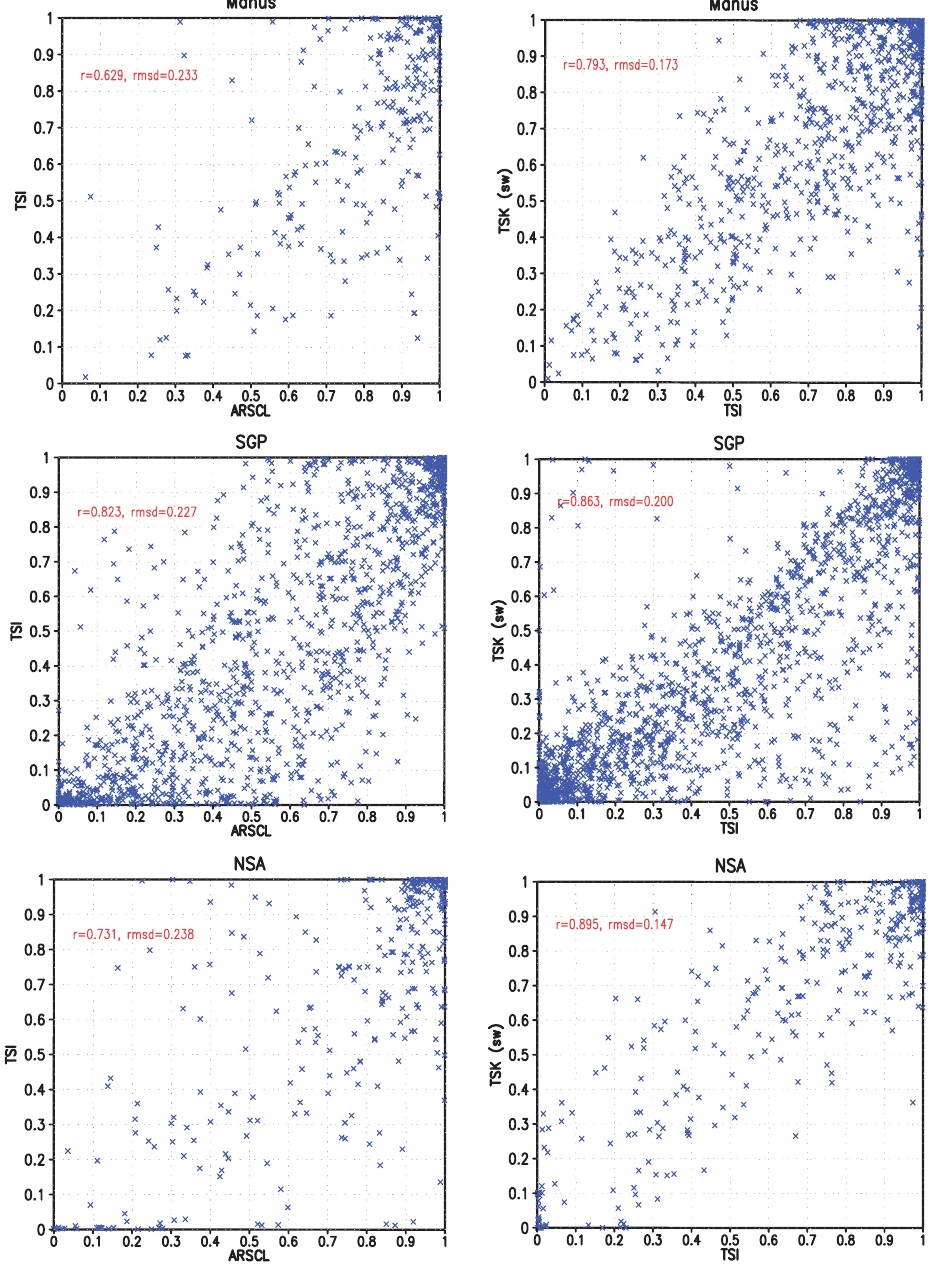
Fig. 2. The scatter plots for daily total sky cover or cloud fraction based on ARSCL and TSI (left) and TSI and TSK (right) over Manus (top), SGP (middle) and NSA (bottom). Only the days when both datasets are available are included in each plot. At NSA only days from April to September (when solar elevation is high enough for reliable TSI and TSK measurements) are used. For each panel, the correlation coefficient and root mean square deviation (RMSD) are